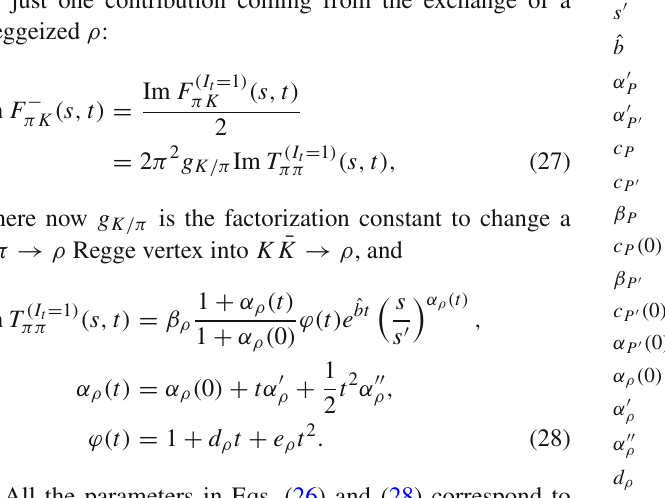
Table 6 Values of Regge parameters obtained in [14,17]. Since these could be fixed using reactions other than π K scattering, they will be fixed both in our UFD and CFD parameterizations Regge